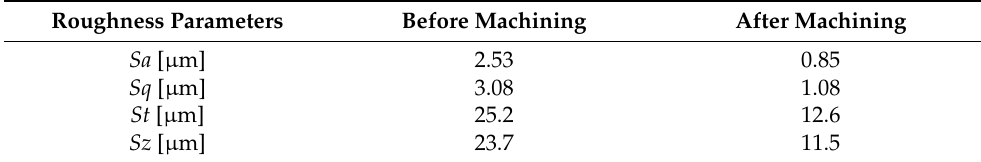
Figure 22. Stereometric surface image after machining: concentration of abrasive grains K = 50%, processing time T = 7 min, machining gap S = 23 mm. Table 7. Selected 3D roughness parameters.